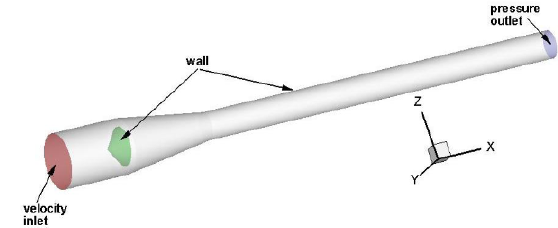
Figure 1. The generated structured mesh for the computational do- main.